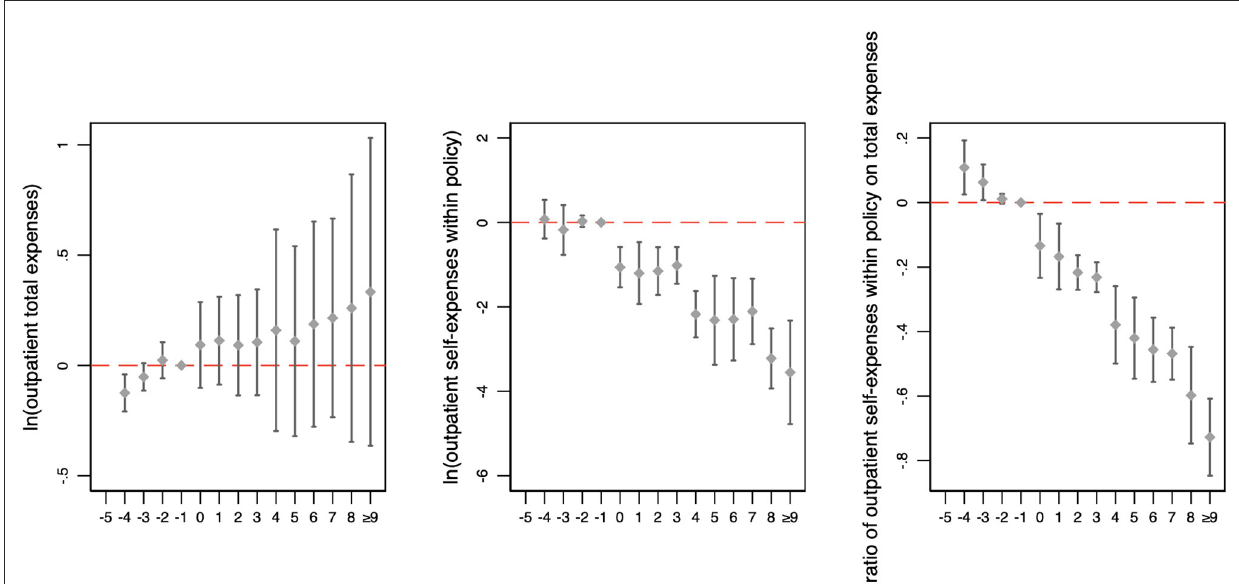
FIGURE2 Changes in outpatient medical expenses and cost-sharing ratios over time. The figure illustrates the coefficient and 90% confidence intervals generated by event study. The horizontal axis represents the number of months relative to the month of policy change implementation.